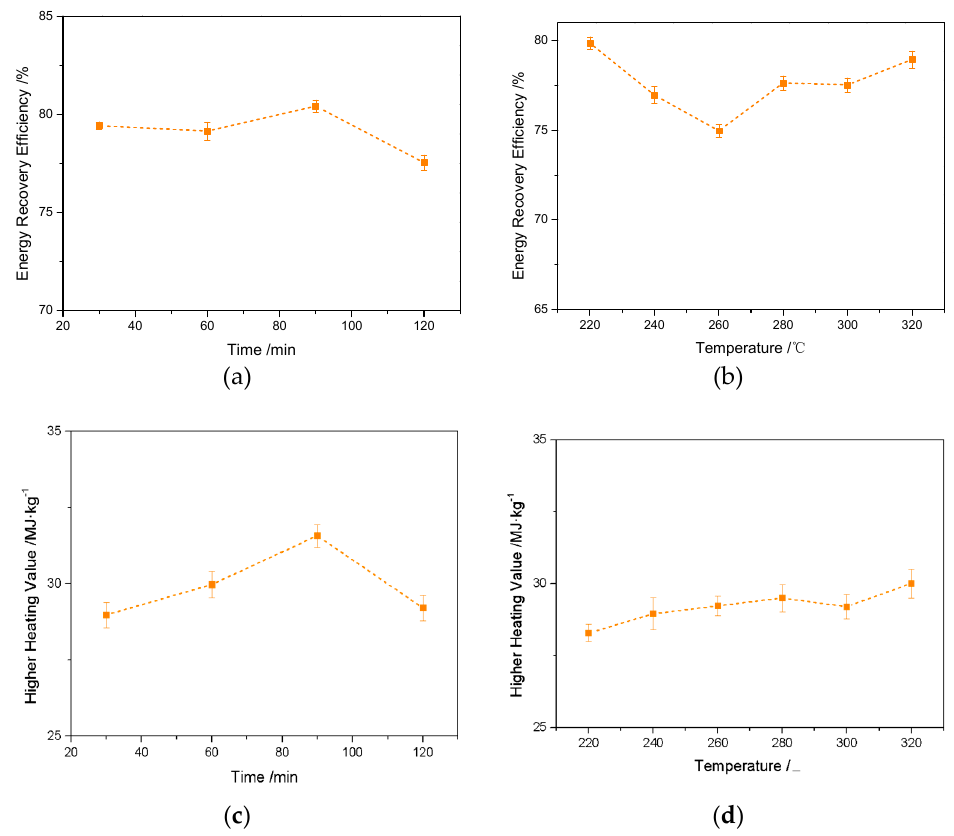
Figure 2. Energy recovery efficiency and higher heating value of hydrochar after hydrothermal carbonization (HTC) treatment (residence time (300 °C) and reaction temperature (120 min). ( a ) Residence time; ( b ) reaction temperature; ( c ) residence time; ( d ) reaction temperature.